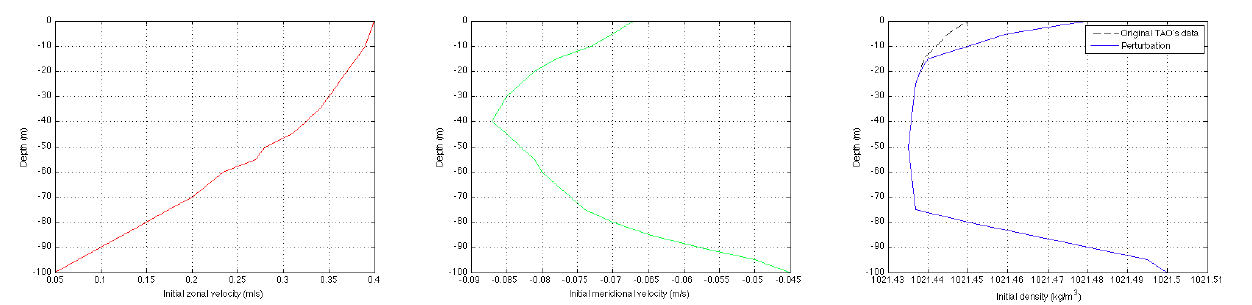
Fig. 7. Test 2: initial zonal velocity, meridional velocity and density profiles (from left to right).